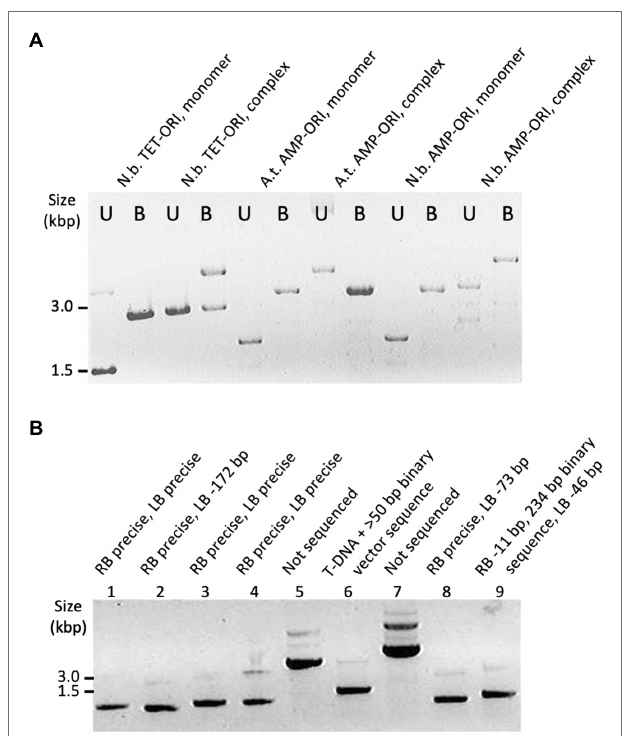
FIGURE 2 | Examples of T-circle analyzed by agarose gel electrophoresis. (A) Samples of T-circles either undigested or Bam HI digested (U and B, respectively). T-circles were recovered from infected Nicotiana benthamiana or Arabidopsis plants (N.b. or A.t., respectively, above each lane) using the T-DNA binary vector TET-ORI or AMP-ORI. (B) Samples of T-circles (undigested) and the sequencing result for each junction above each lane. T-circles were isolated from Nicotiana benthamiana using the TET-ORI binary vector.